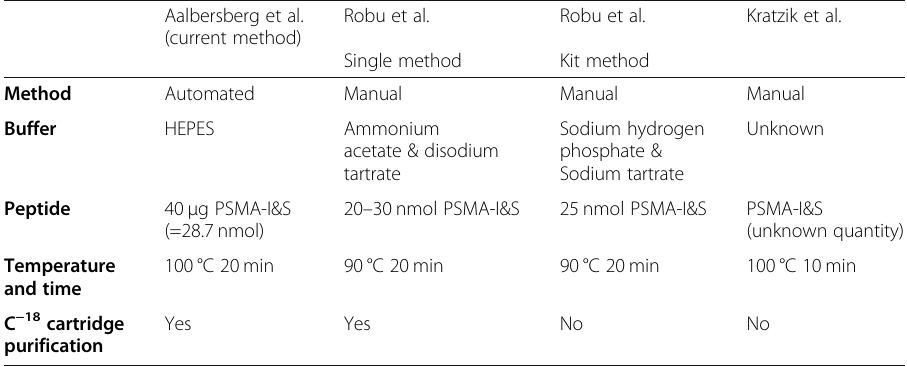
Table 2 Comparison between the automated method described in this article and the methods described in literature Aalbersberg et al. Robu et al. Robu et al. Kratzik et al. (current method) Single method Kit method Method Automated Manual Manual Manual Buffer HEPES tartrate Peptide